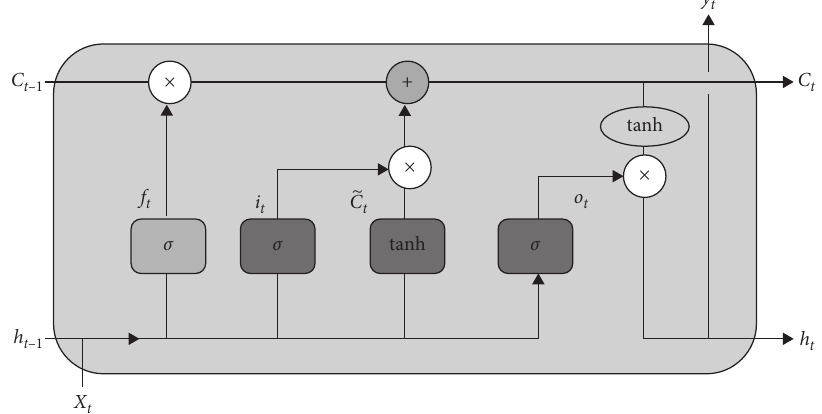
Figure 3: The basic structure of the LSTM neural network.